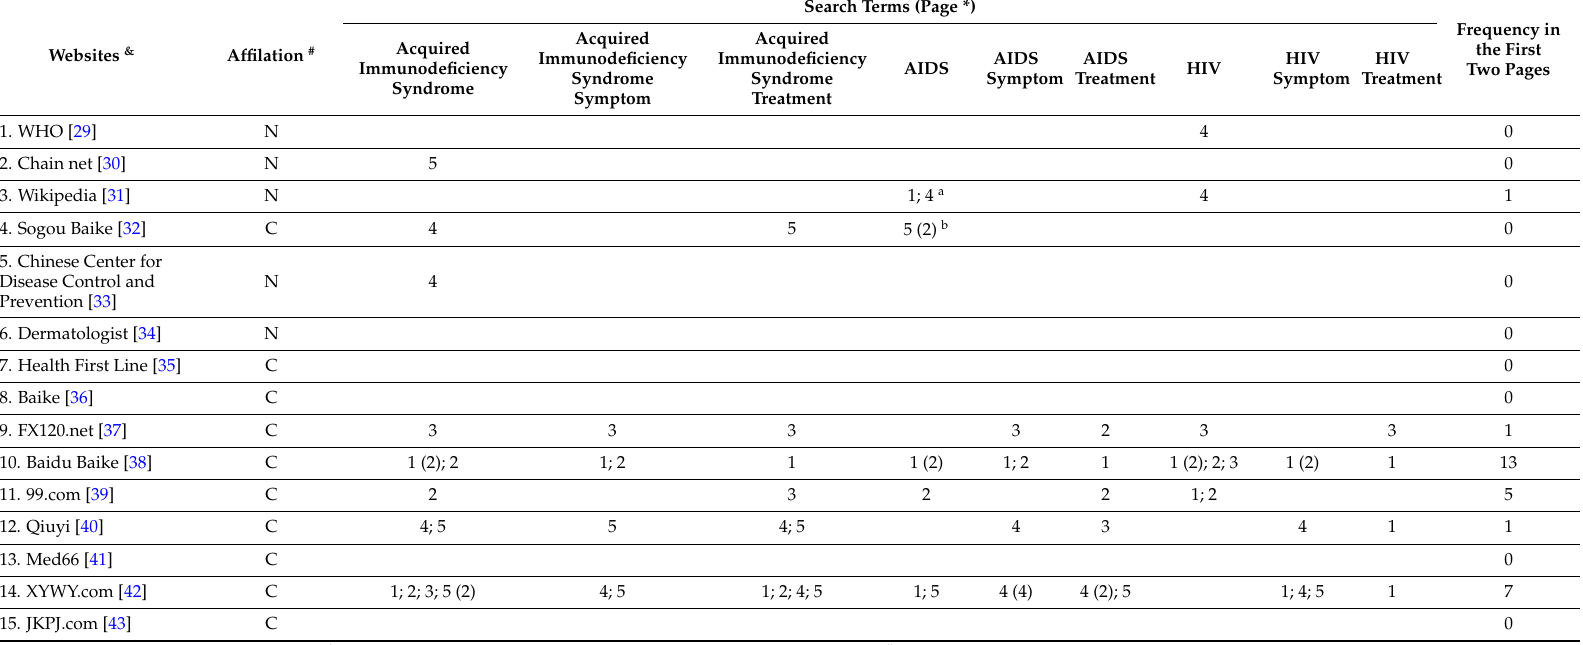
Table 2. The searching results of the top 15 websites obtain from Baidu by each